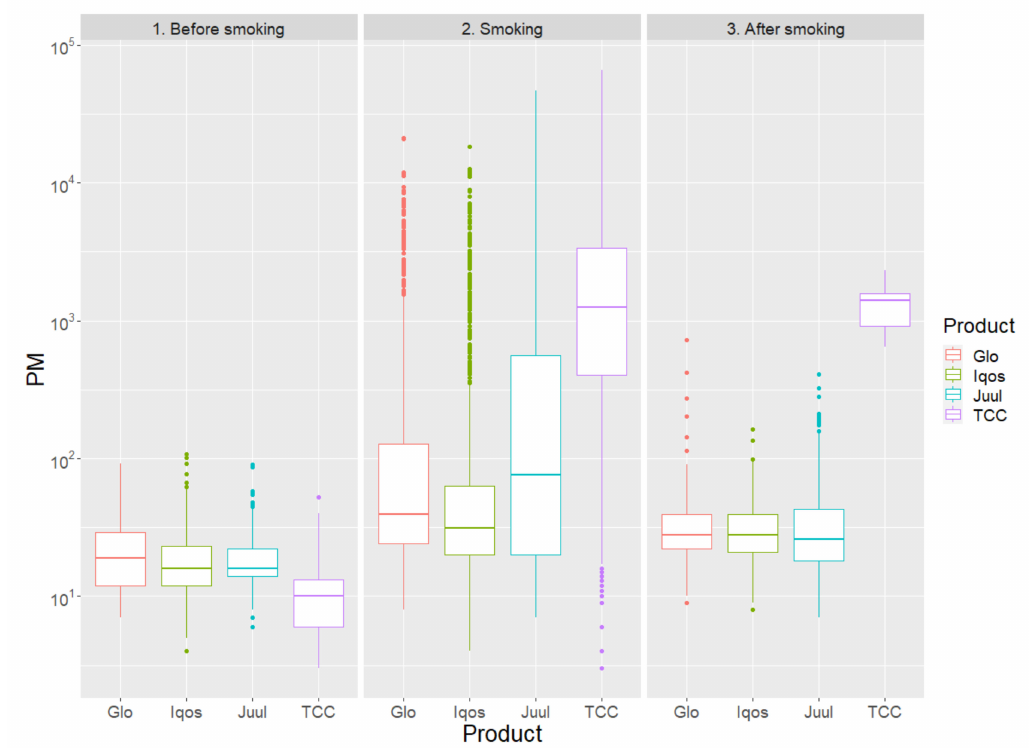
Figure 1. Total particulate matter (PM) concentrations, expressed as µ g / m 3 , comparing Glo, Iqos, Juul, and traditional combustion cigarettes (TCC), distinguishing the following phases: before smoking (1), smoking (2), and after smoking